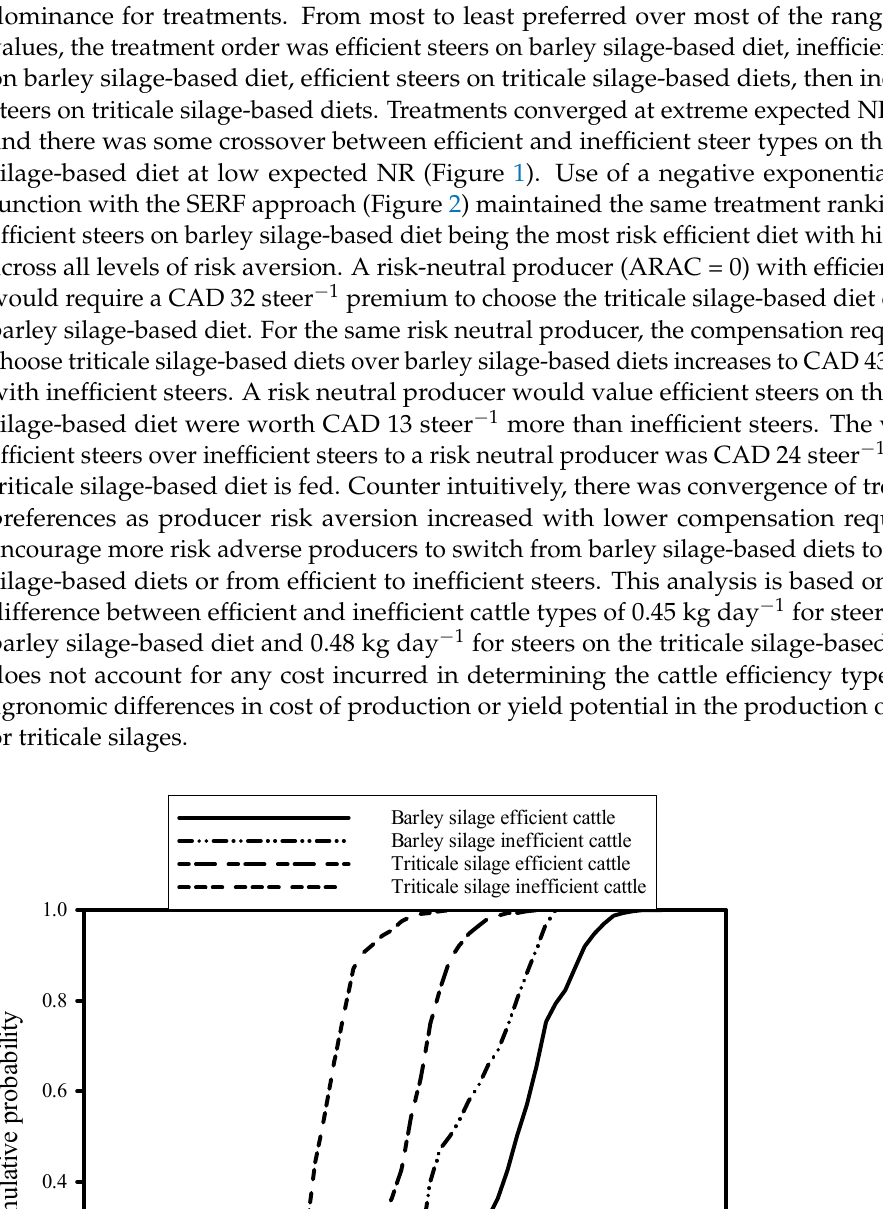
Figure 2. Comparison of certainty equivalent of barley and triticale silage-based diets and cattle efficiency type in beef backgrounding steers. 4. Discussion 4.1. Adequacy of RFI Predictions Use of predicted RFI in analyzing the effects of RFI is only sensible if there is good agreement between predicted and observed pen average RFI. By definition, the average observed RFI for a contemporary group, all pens of steers in a given year of background- ing for our study, is zero and was very close to the average predicted RFI in year 1 (0.016 kg) and year 2 (0.014 kg). The stated accuracy for individual steer RFI molecular breeding values averaged 0.35 in year 1 and 0.37 in year 2. This indicates good accuracy. However, good agreement also requires precision. There was a lack of precision with the genomic- based estimates of RFI. The individually predicted RFI values used in assigning cattle to efficiency quartiles and randomizing steers to pens were therefore unsuitable for basing statistical analyses on. This was the reason why our analyses approach changed from a